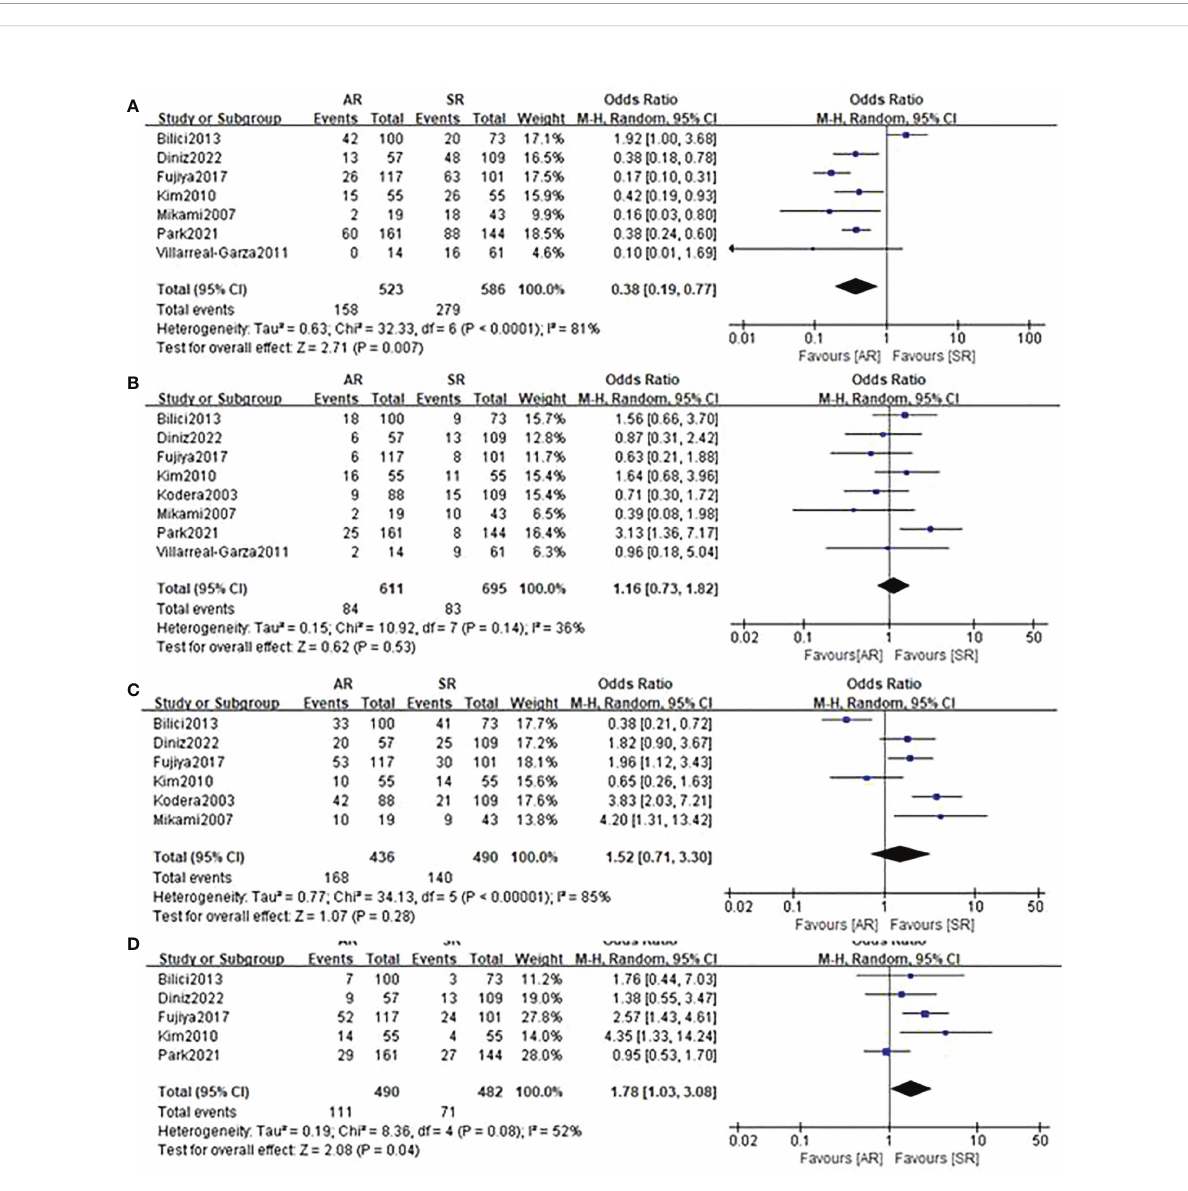
FIGURE 5 Forest plot assessing recurrence patterns including (A) peritoneal recurrence, (B) locoregional recurrence, (C) hematogenous recurrence, (D) distant lymph node metastasis between the asymptomatic and symptomatic recurrence